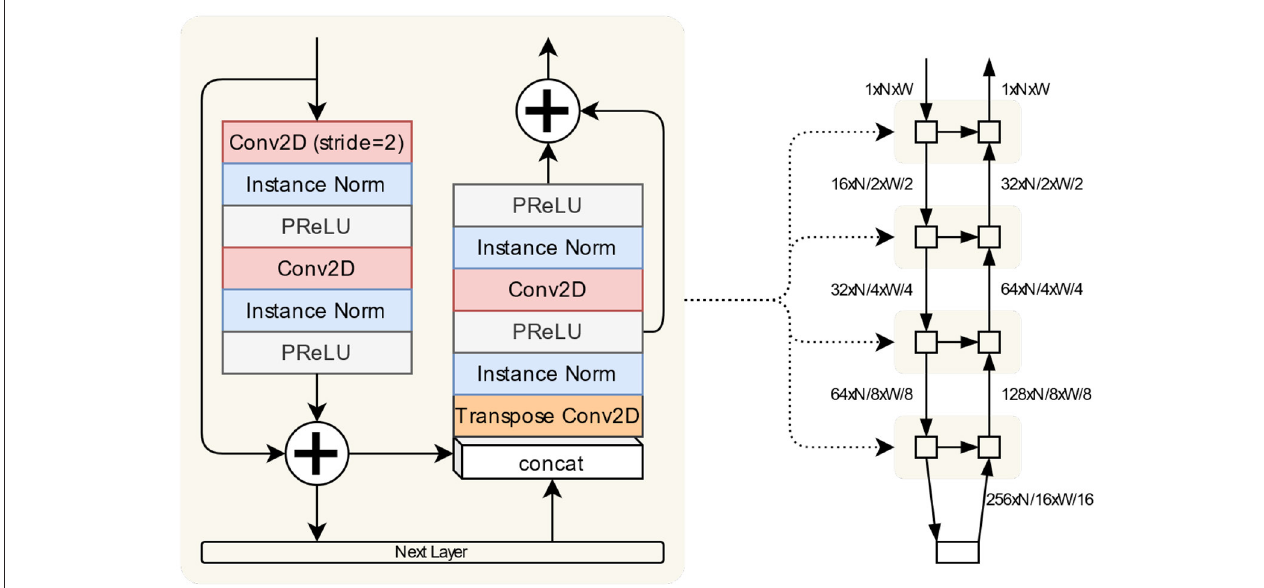
FIGURE 1 | The segmentation network is implemented as a stack of blocks illustrated here. The encode and decode paths along with the skip connection are defined in the same block. The “Next Layer” is either another such block or the bottom encoding block comprised of convolution/normalisation/activation sequences. The overall structure of the network is shown on the right, with the dimensions of tensors passing between layers given relative to an input of shape (1, N,